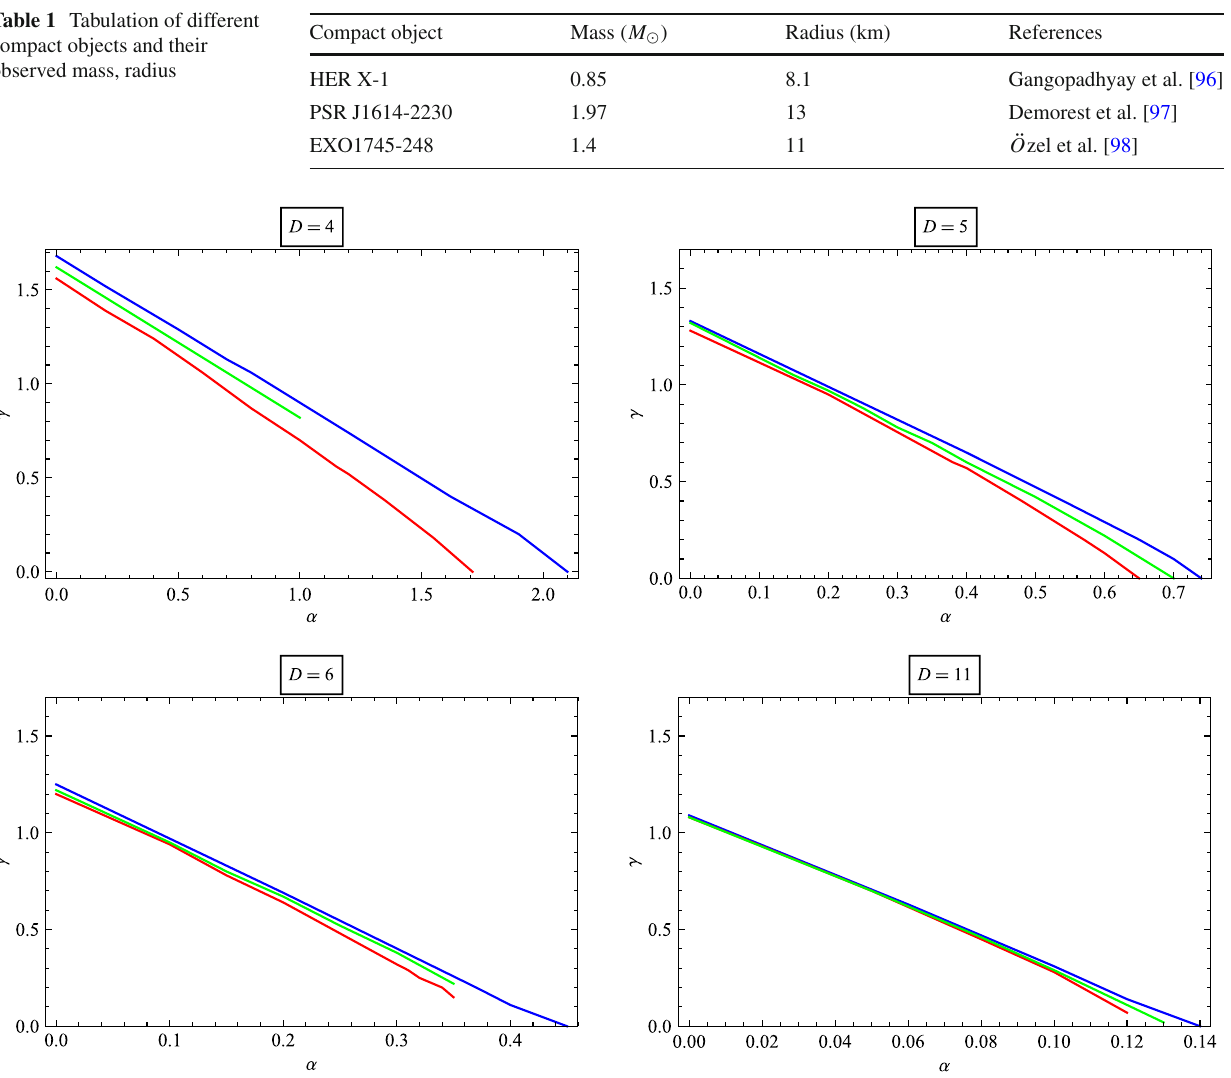
Fig. 1 Plots of γ against α corresponding to different central pressure for HER X-1 (blue line), EXO1745-248 (green line) and PSR J1614- 2230 (red line). Here the regions below each line represent allowed combinations of α and γ for which positive value of central pressure